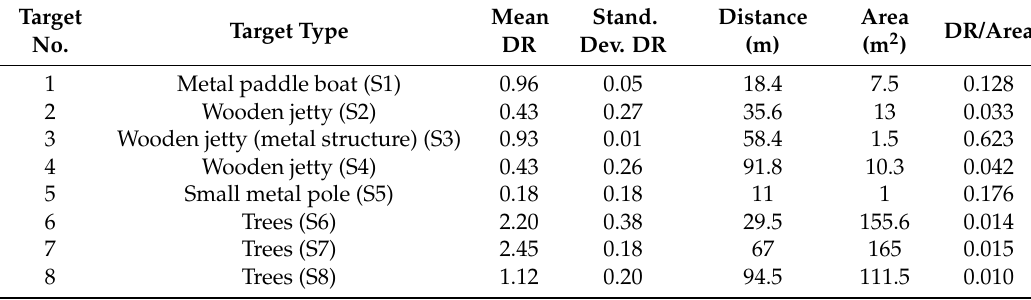
Table 6. Analysis of the possibility of detection for the static scenario.